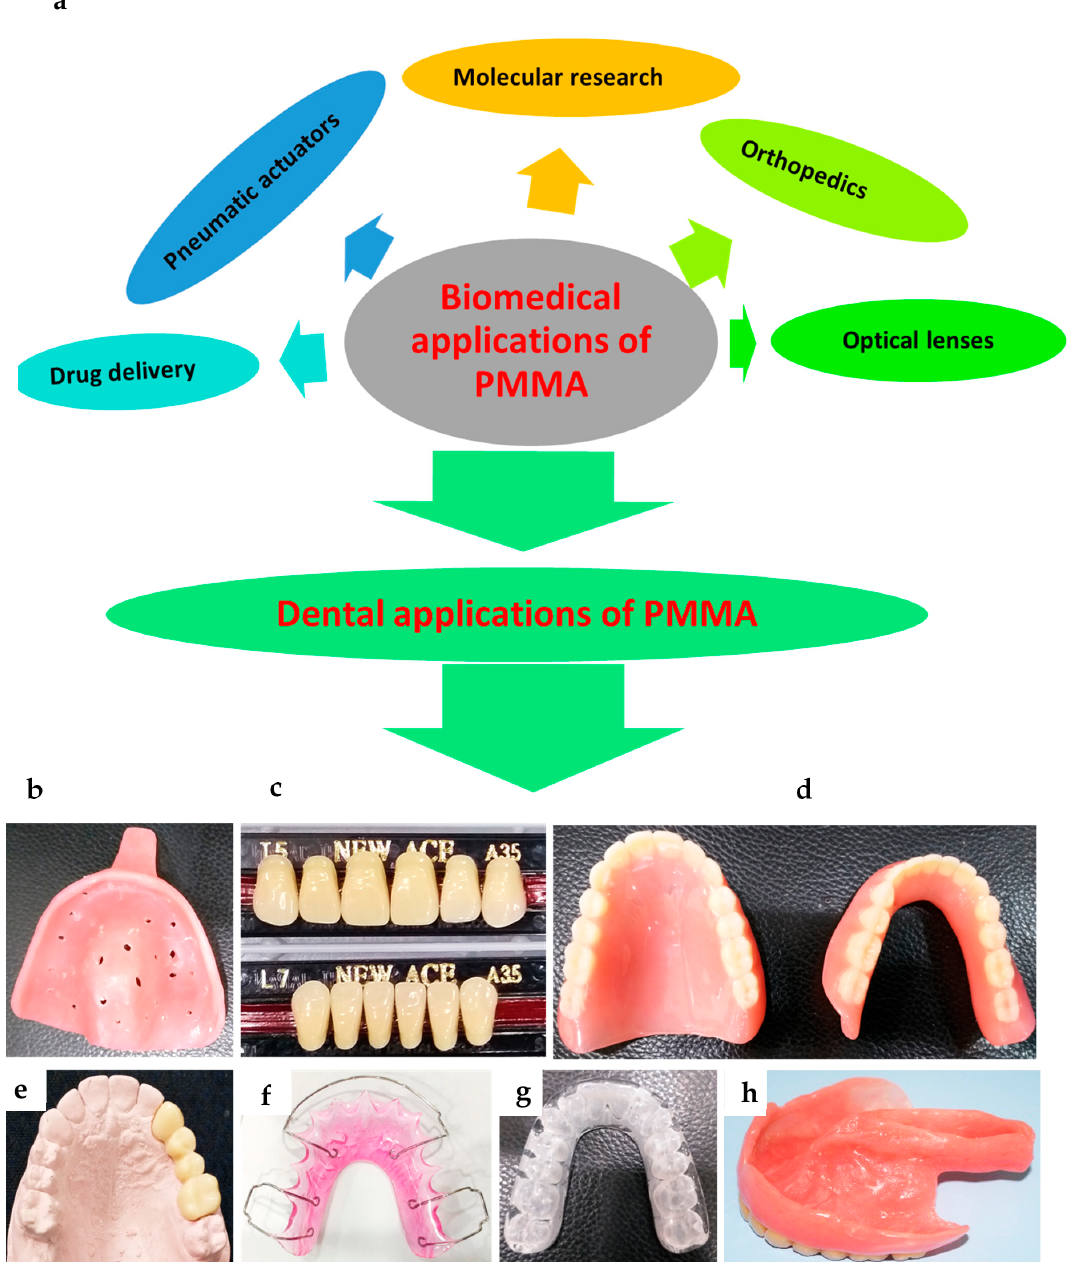
Figure 4. Key applications of PMMA: ( a ) in various biomedical disciplines; ( b ) secondary impression tray; ( c ) acrylic artificial teeth; ( d ) denture with acrylic teeth; ( e ) provisional fixed partial denture, crown; ( f ) orthodontic retainer; ( g ) occlusal splint; ( h ) palatal obturator replacing lost tissue following maxillectomy.